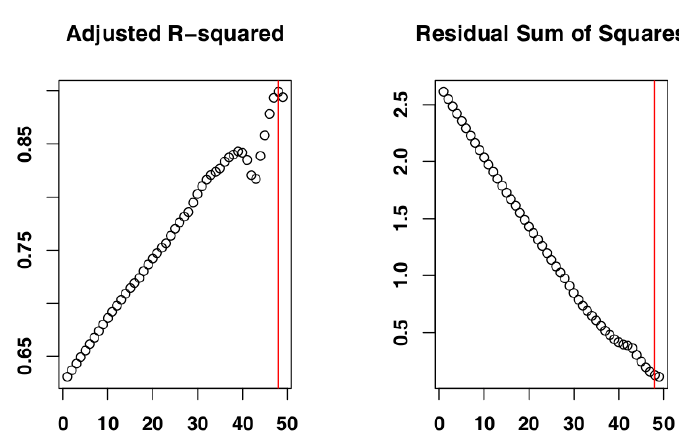
Figure 7. Adjusted R-squared and residual sum of squares (RSS) values for Belgium data. The red line indicates the values returned by the selected subset. Numbers on the x -axis are the iteration IDs.